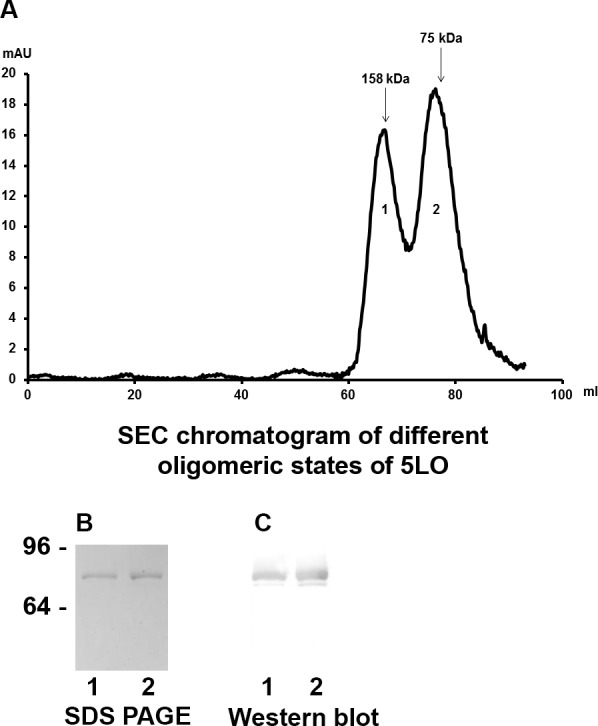
Recombinant 5LO exist as monomer as well as dimer.(A), Size exclusion chromatography of 5LO. Arrows indicate elution of standard proteins: Aldolase (158 kDa), Conalbumin (75 kDa). Peak 1 (retention volume 66 ml) corresponds to 5LO dimer. Peak 2 (retention volume 78 ml) corresponds to 5LO monomer. (B and C) SDS-PAGE of material in SEC peaks (lanes 1, from peak1; lanes 2, from peak 2) (B) Coomassie stained gel. (C) Western blot with 5LO antibody.